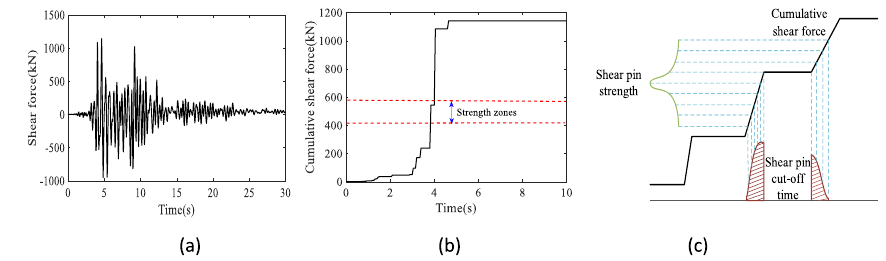
Fig. 6 The relations between cumulative shear force and cut-off time: a shear force; b cumulative shear force; and c cut-off